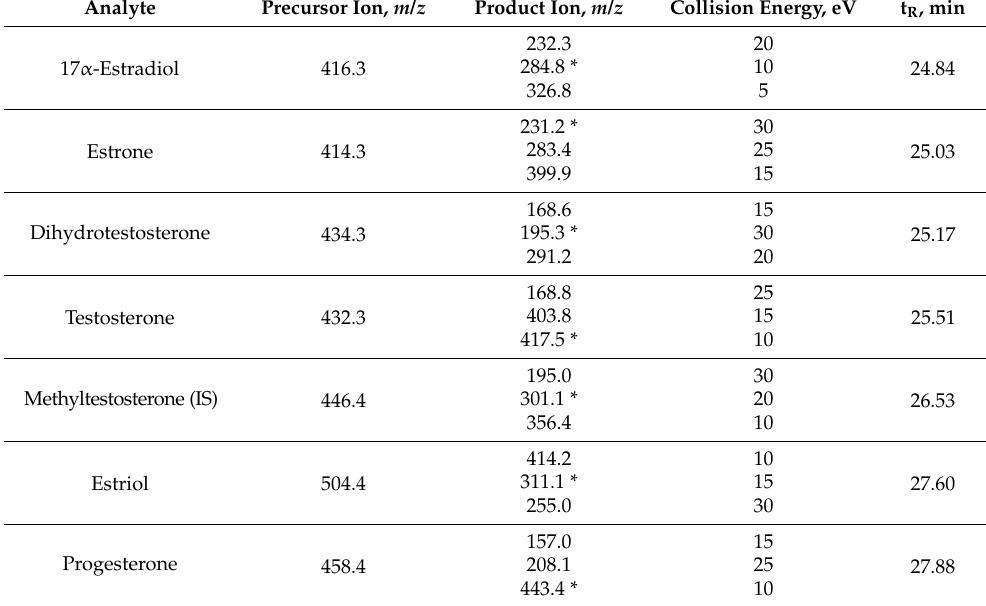
Table 2. Optimized MRM-transitions for steroid hormones